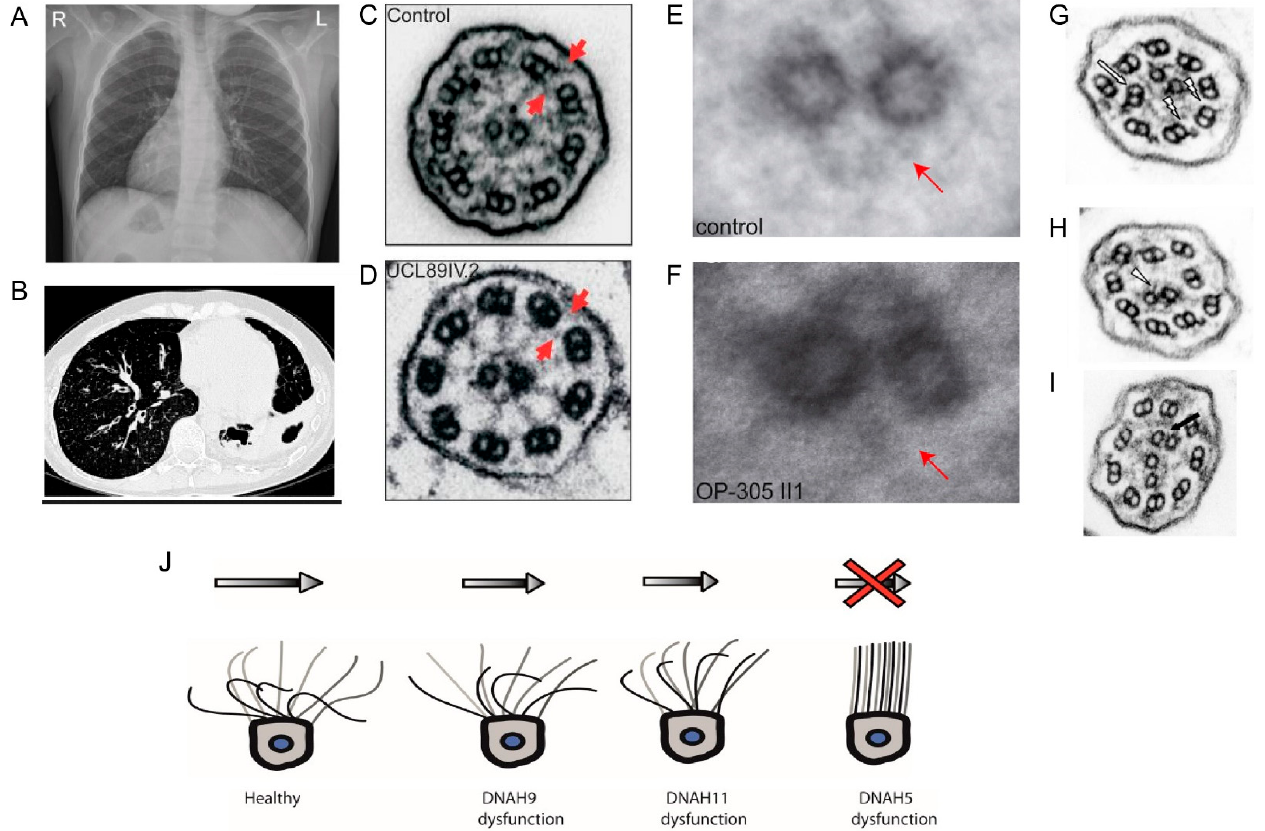
Figure 8. The clinical phenotype of PCD and the representative EM defects observed. ( A ) Chest X ray of patient showing situs inversus, reprinted with permission from Loges et al. Am J Hum Genet. 2018 Dec 6; 103 (6):995–1008 [158]. ( B ) PCD patient with bronchiectasis of the right and left lower lobes, reprinted with permission from Onoufriadis et al. Am J Hum Genet. 2013 Jan 10; 92(1):88–98 [150]. ( C – I ) Cross section of the cilia with ultra-structural defects in comparison with the control. ( C ) Control with outer and inner dynein arms (red arrows); ( D ) DNAAF3 patient’s cilia lacking both outer and inner dynein arms (arrows), reprinted with permission from Mitchison et al. Nat Genet. 2012 Mar 4;44(4):381–389 [159]. ( E ) Control with central pair appendage (arrow) and ( F ) Hydin patient cilia with missing central pair appendage (arrow) visualized by image averaging, reprinted with permission from Olbrich et al. Am J Hum Genet. 2012 Oct 5; 91(4):672–684 [160] ( G ) disorganized peripheral microtubules and ( H ) acentric central pair, as well as ( I ) supernumerary central pairs seen in the cilia of CCDC40 patients, reprinted with permission from Antony et al.Hum Mutat. 2013 Mar; 34(3):462–472 [161]. ( J ) Graphical demonstration of a normal motile cilia movement pattern compared with the pattern observed in DNAH9 dysfunction (immotile distal half), DNAH11 dysfunction (immotile proximal half), and DNAH5 dysfunction (complete immobility), with recovery strokes shown in black.